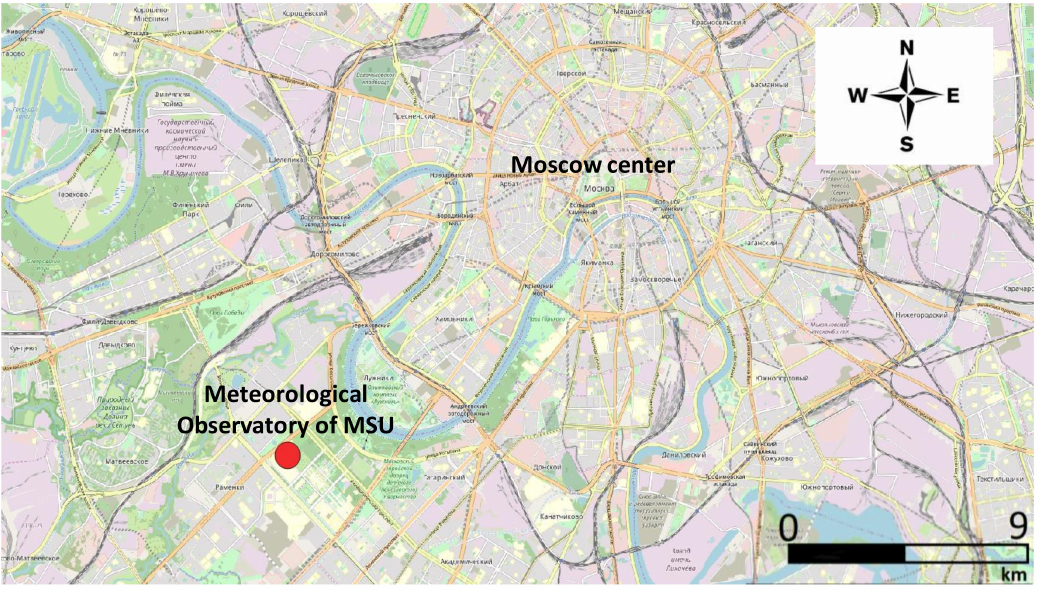
Figure 1. Map of Moscow city. Meteorological station of Moscow State University is